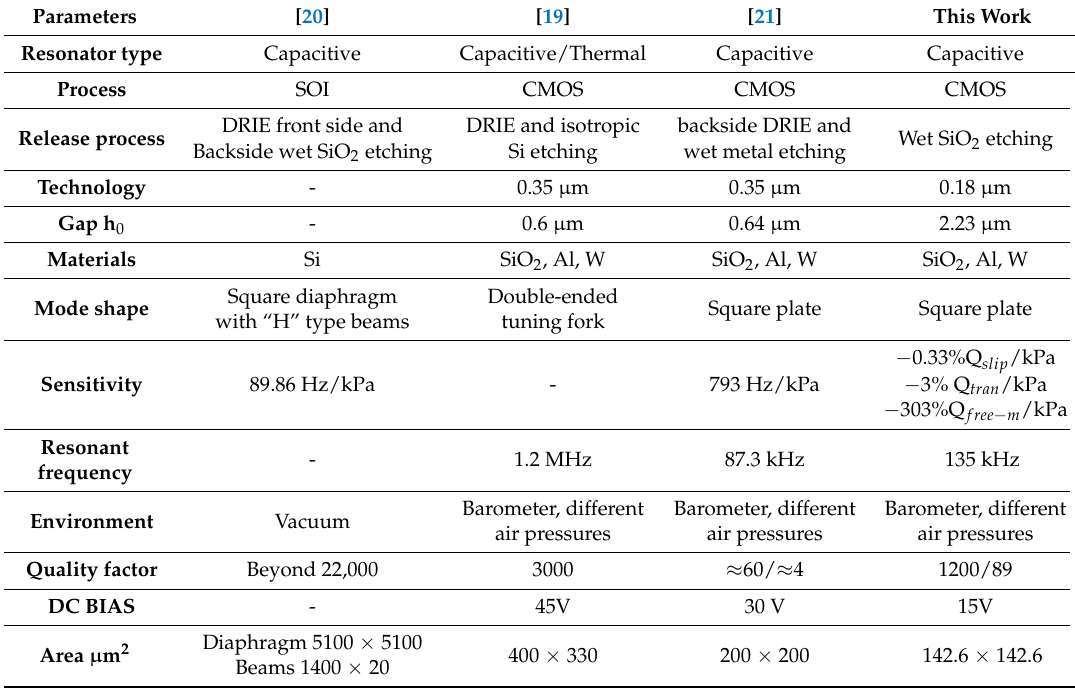
Table 4. Summary of comparison of the sensor presented in this work along with other MEMS pressure resonant sensors previously